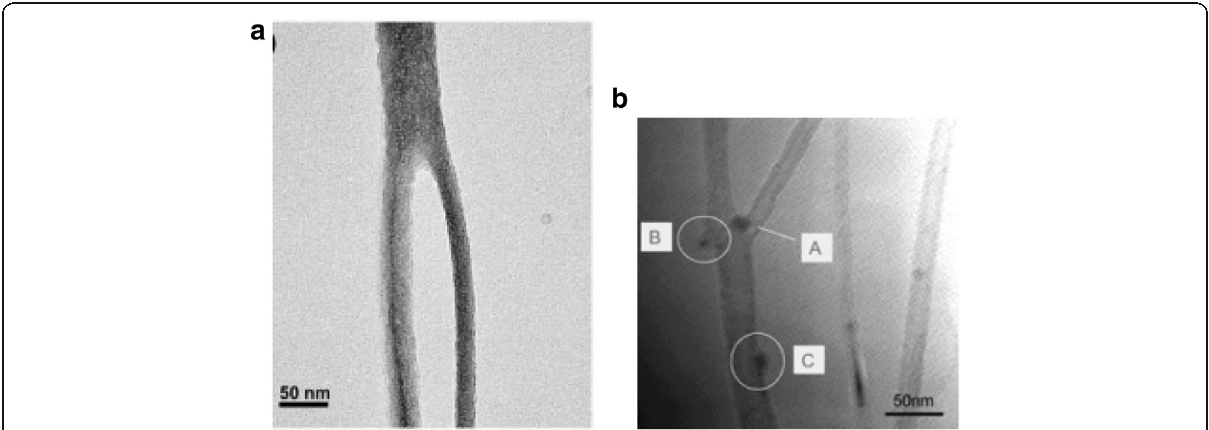
Fig. 18 a TEM image of a MWCNT Y-junction nanotube grown by CVD using branched nanochannel anodic alumina templates. The grown Y-junctions were reported to be 6 to 10 μ m in length with tunable diameters. Adapted from [159]. b TEM image of MWCNT Y-junction nanotube grown using Ti- doped Fe catalysts. Catalyst present at the junction (shown as A) leads to the formation of the two branches. B shows a Y-junction grown from catalyst particles that attach on the walls of the nanotube. C represents a catalyst nanoparticle that does not lead to further branching. Adapted from [161]